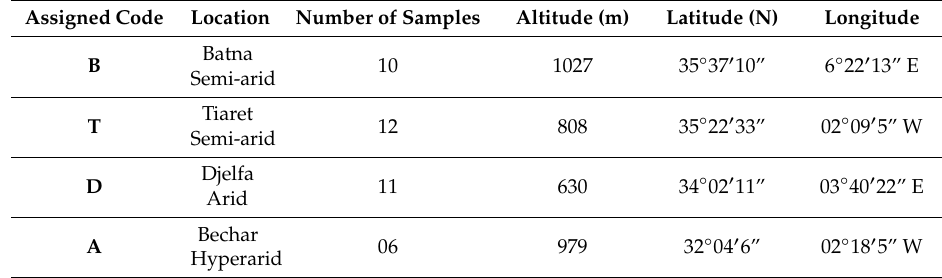
Table 3. Geographical locations and numbers of samples collected from each P. atlantica Desf. population